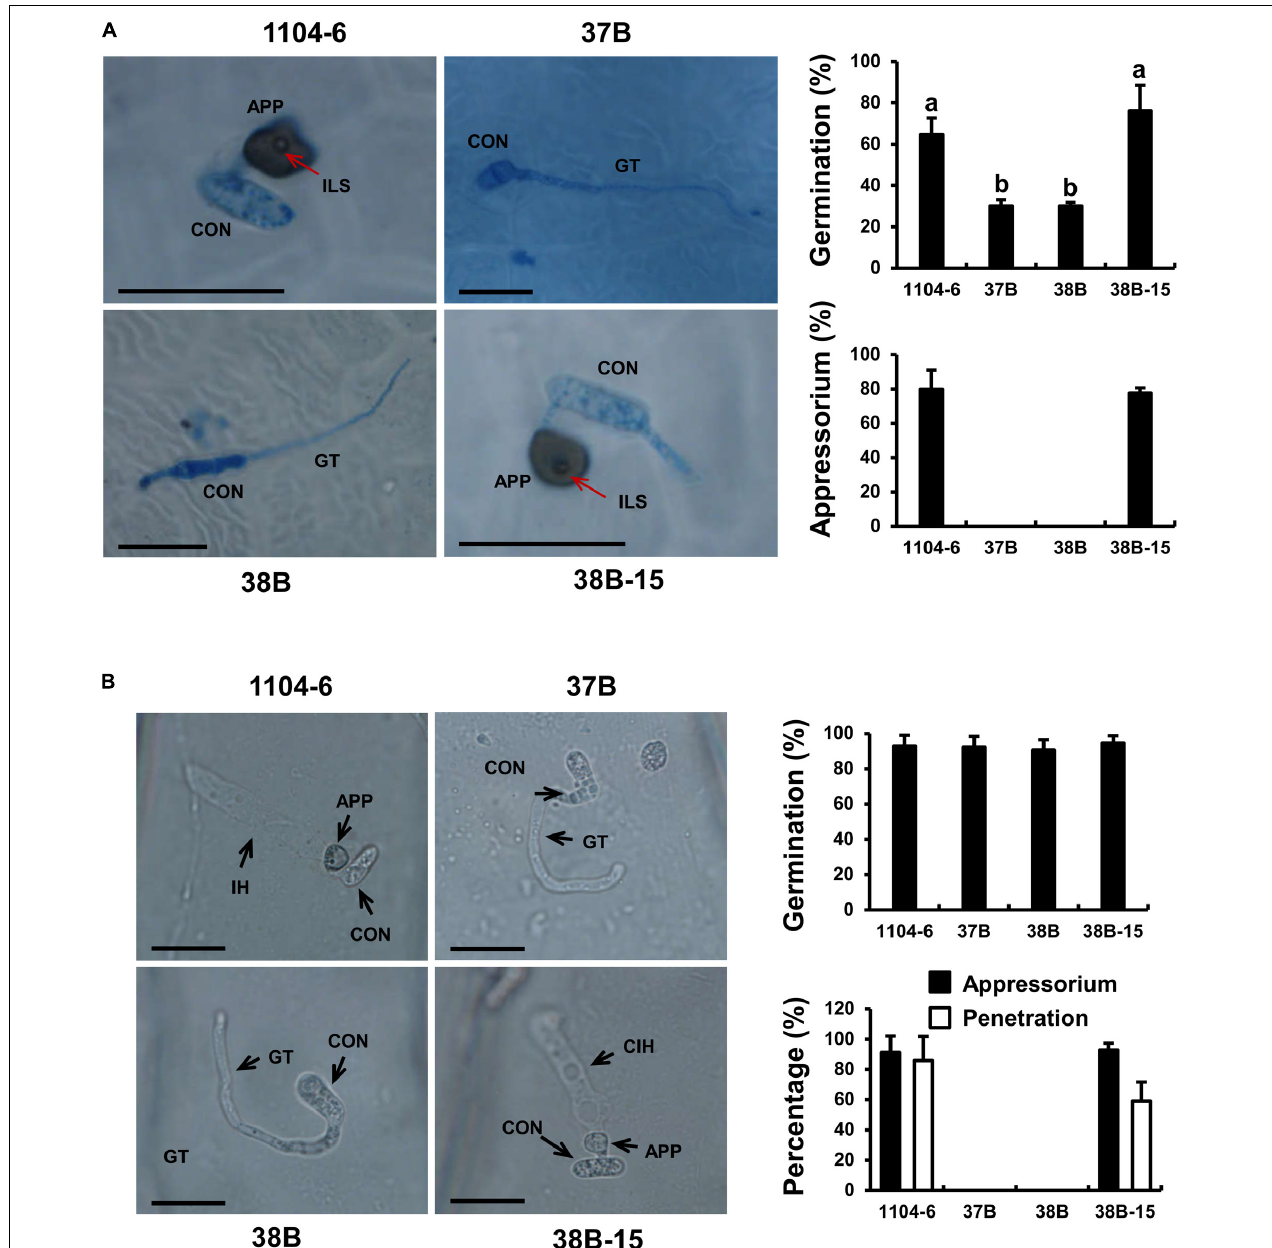
FIGURE 6 | The CfPMK1 gene is required for appressorium development. (A) Conidial germination and appressorium development of different strains on apple leaf surfaces. Apple leaves were sampled at 24 hpi for microscopic observation. “a” and “b” indicate significant difference at P = 0.05 according to Tukey’s HSD test following one-way ANOVA analysis. (B) Conidial germination and appressorium development of different strains on onion epidermal peels. In (A,B) , scale bar indicates 20 µ m. CON, conidium; GT, germ tube; APP, appressorium; ILS, internal light spot; IH, infectious